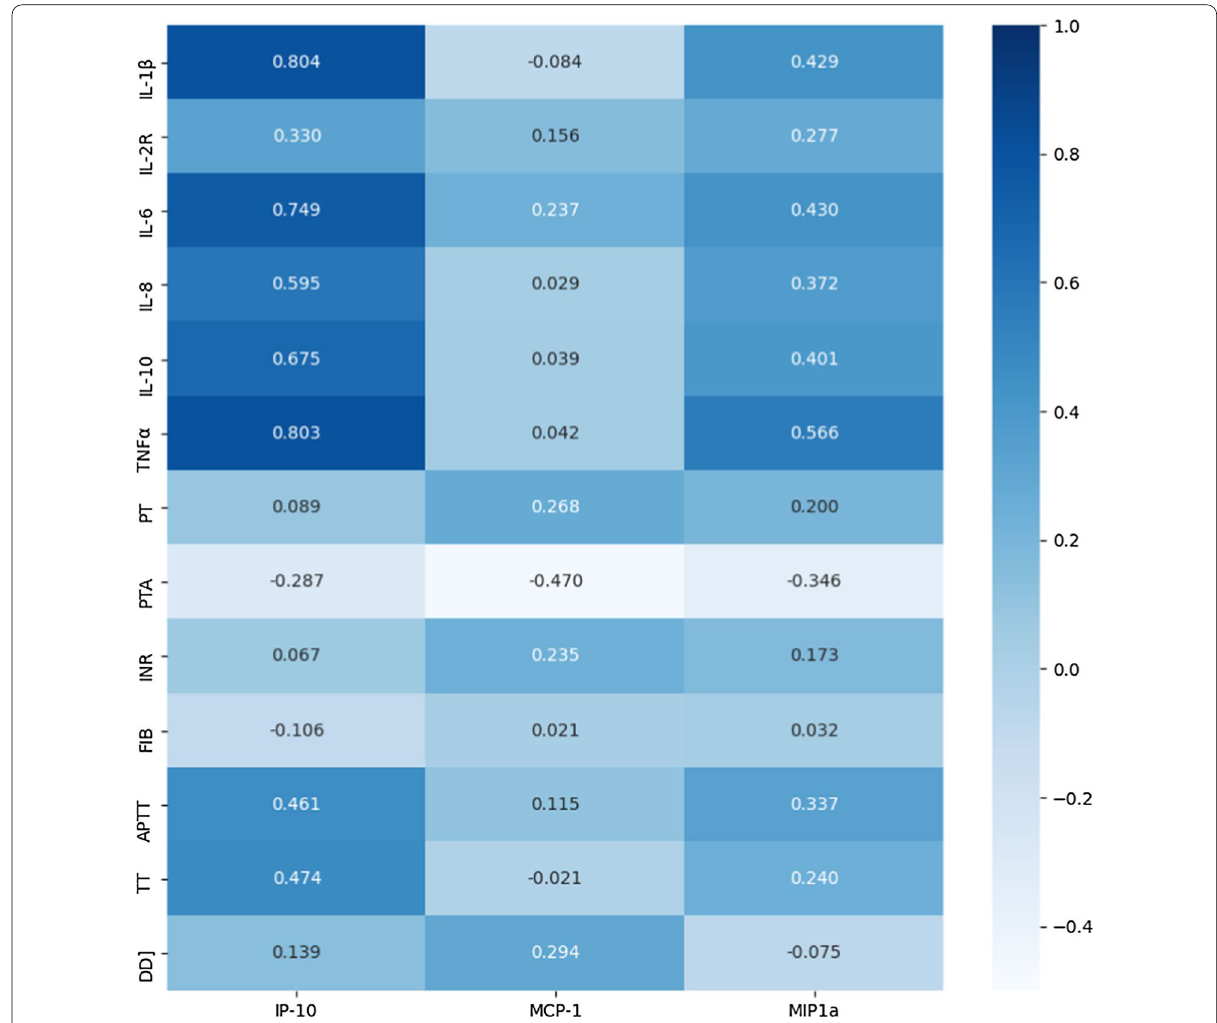
Fig. 5 Correlation analysis among coagulation and thrombosis-related ELISA indicators, cytokines and coagulation-related